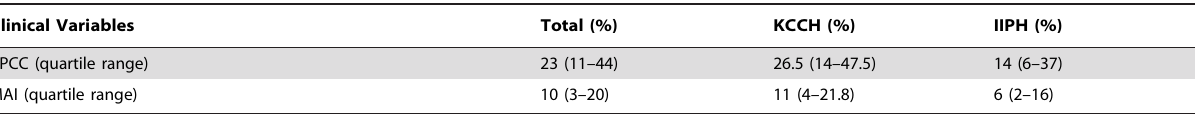
Clinical Variables